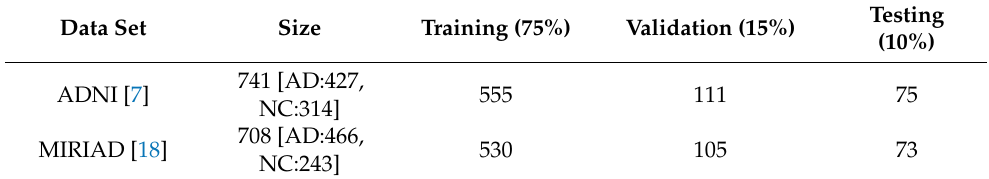
Table 2. Datasets